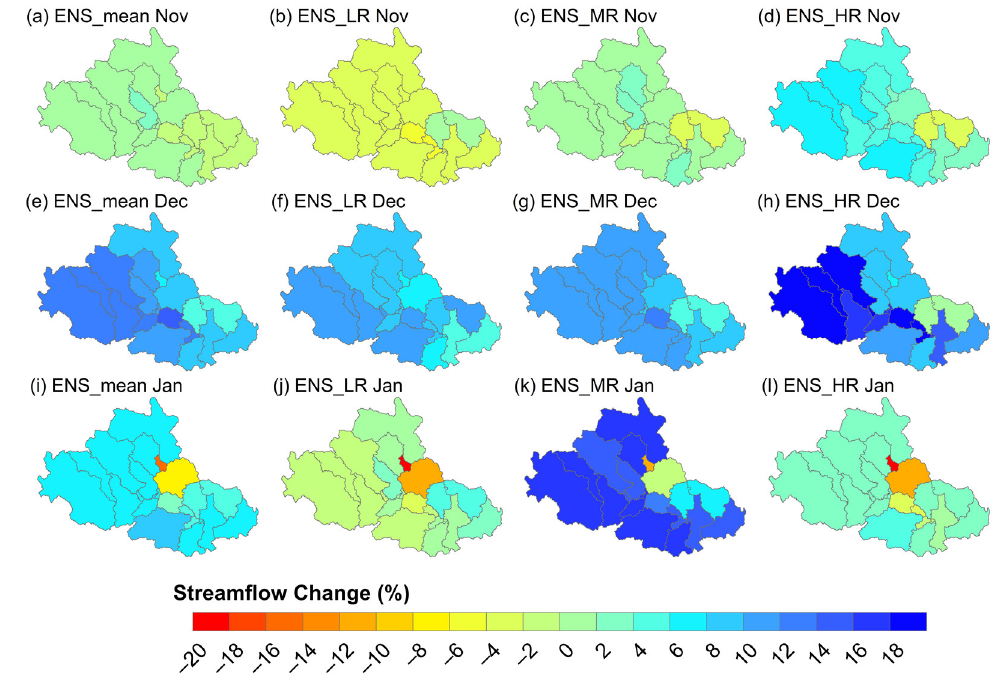
Figure 6. The percentage change of monthly streamflow during the flood periods of November ( a , b , c , d ), December ( e , f , g , h ) and January ( i , j , k , l ) projected by the CMIP6 HighResMIP models.